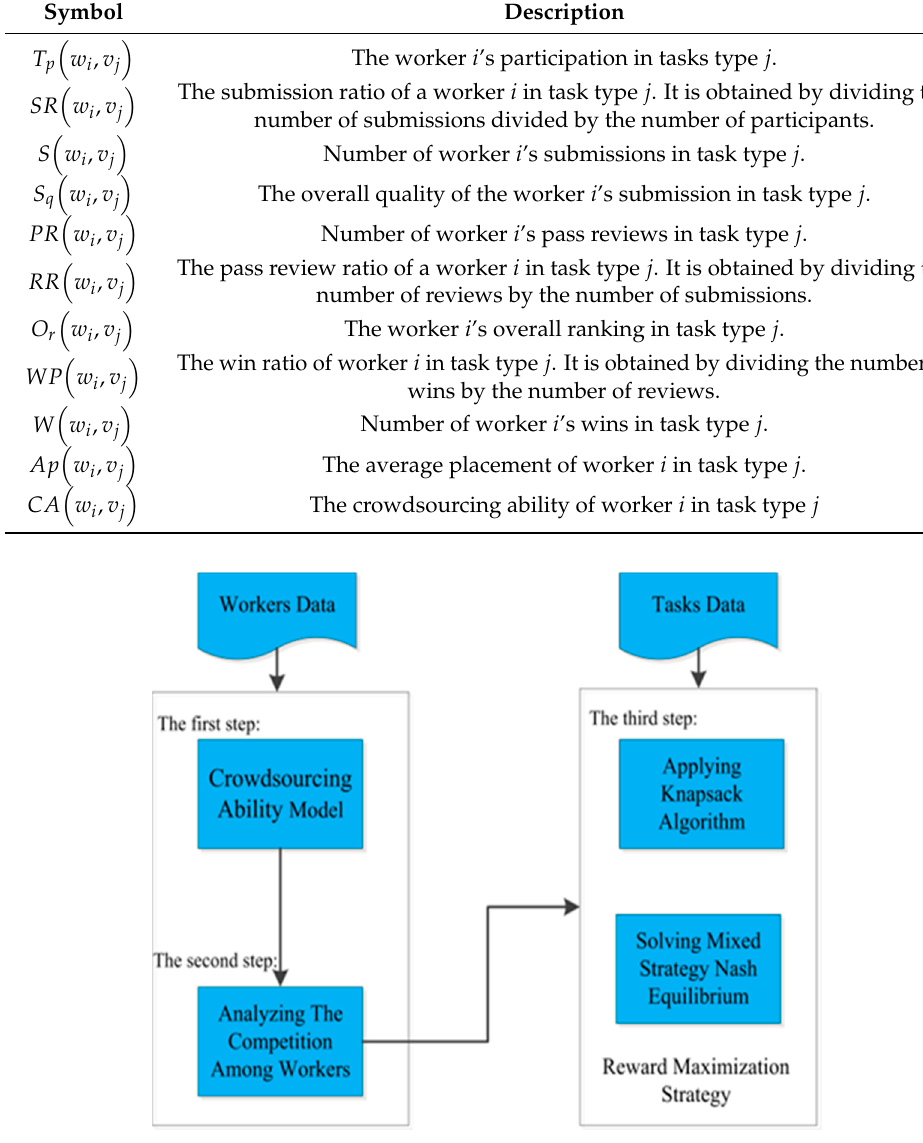
Figure 2. Research steps: Step one, building the crowdsourcing ability model; step two, analyzing the competition among workers; and step three, obtaining reward maximization strategy by using knapsack algorithm and constructing game